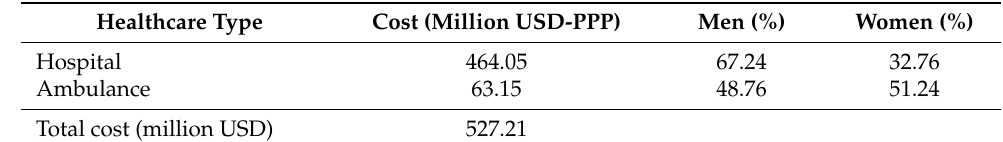
Table 4. Healthcare cost attributable to alcohol in million USD, 2017.